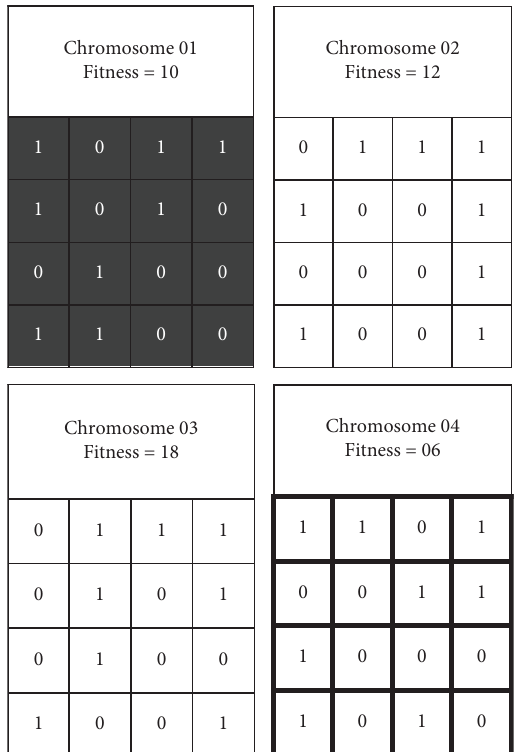
Figure 3: Randomly selected initial population of four chromo- somes, satisfying row aggregates.